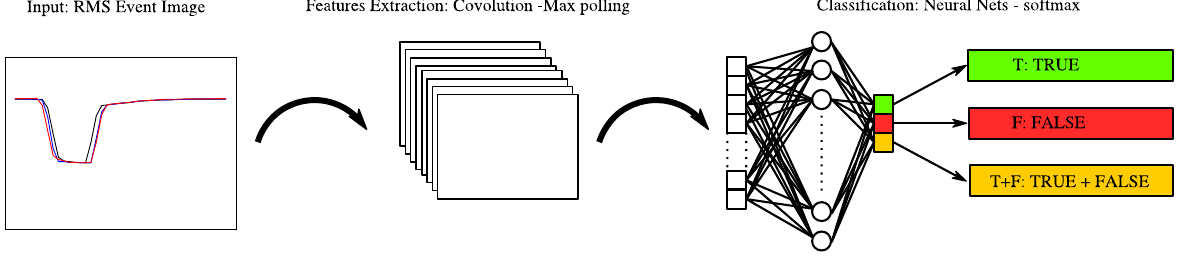
Figure 5. DELFI Figure 5. DELFI architecture.